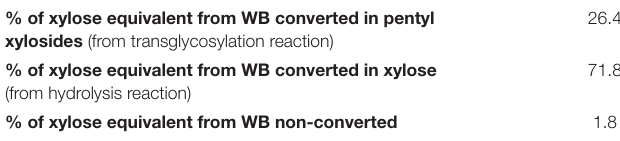
TABLE 2 | % of xylose from WB converted into pentyl xylosides (DP1–DP3), into xylose, % of non-converted xylose after 48 h of transglycosylation reaction catalyzed by Cellic Ctec2 in the presence of WB and pentanol 50% in